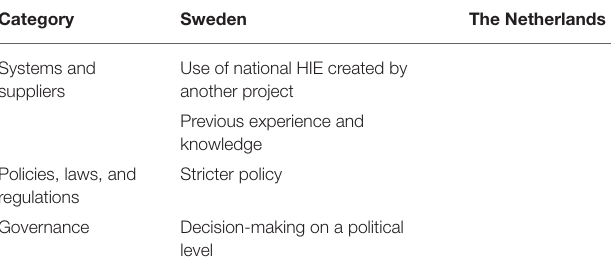
TABLE 6 | Facilitators on the local implementation